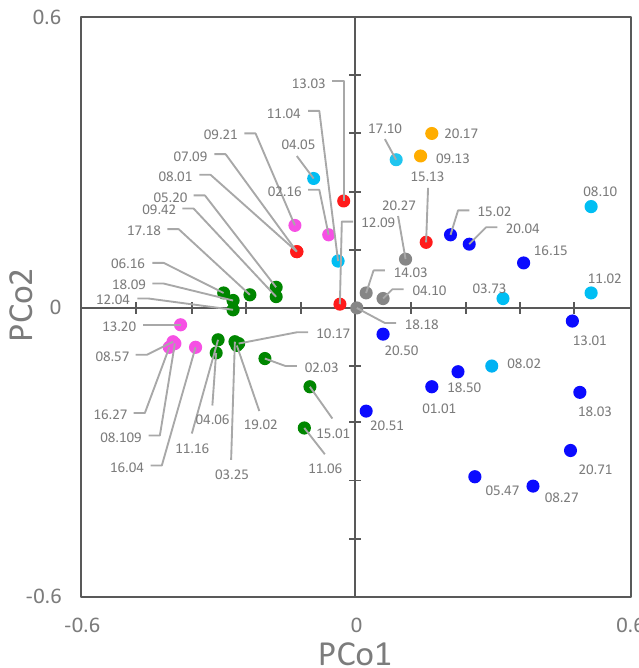
Figure 7. 2D Principal Coordinate Analysis (PCoA) visualization of E. coli strains, computed from the Dice’s distance matrix of genetic and phenotypic determinants. Strains are colored based on their phylogroup: A, cyan; B1, blue; B2, green; C, yellow; D, red; E, grey; F, pink.